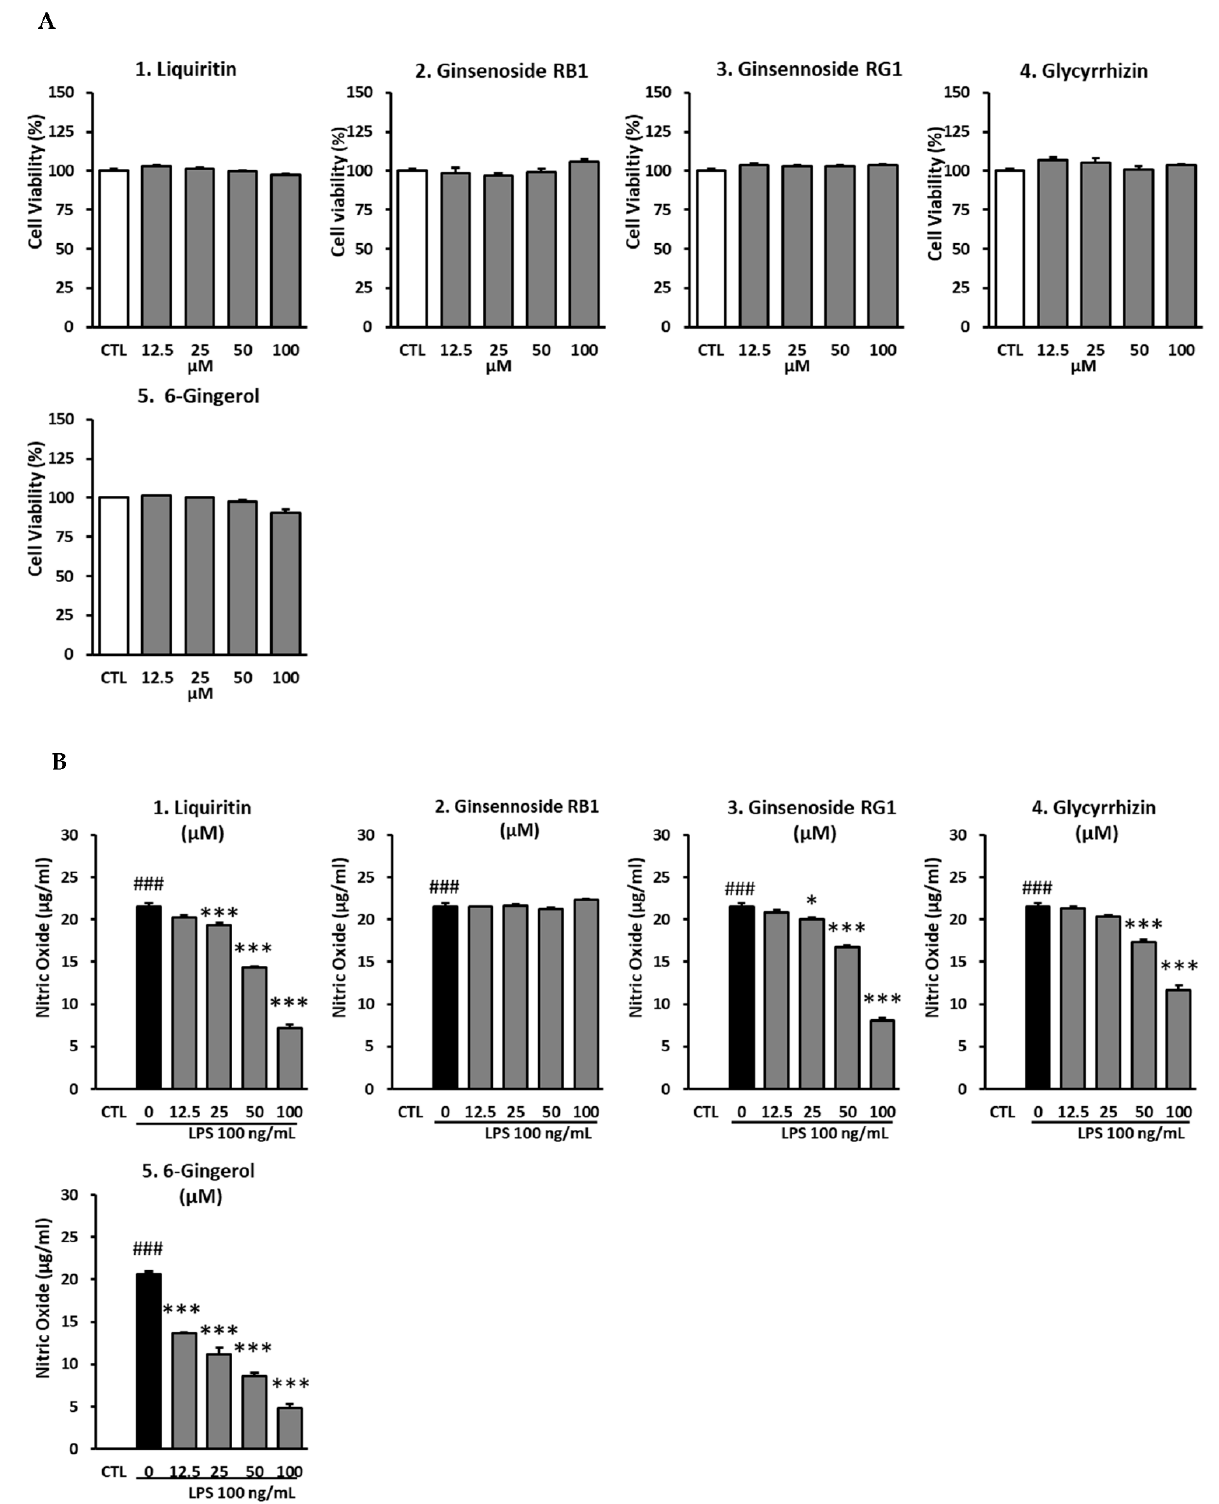
Figure 3. Inhibitory effects of liquiritin, ginsenoside Rb1, ginsenoside Rg1, glycyrrhizin, and 6-gingerol in RAW 264.7 cells. The cells were pre-treated with various concentrations of active compounds from Lizhong-tang (liquiritin, ginsenoside Rb1, ginsenoside Rg1, glycyrrhizin, and 6-gingerol). ( A ): Cytotoxic effects of the active compounds of Lizhong-tang. ( B ): Inhibition of nitric oxide production by the active compounds of Lizhong-tang. RAW 264.7 cells were treated with lipopolysaccharide (LPS; 100 ng/mL) and samples. The data have been represented as mean ± SEM. Statisti-